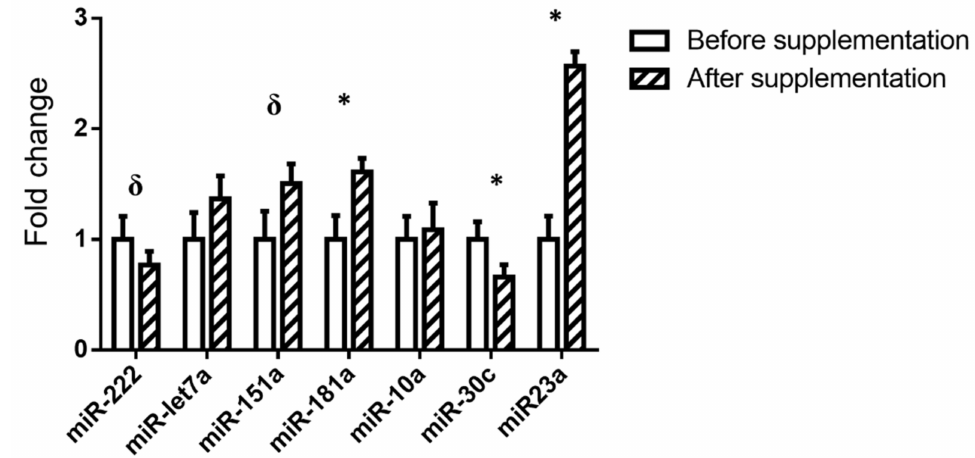
Figure 2. Relative miRNA expression in the whole cohort before and after the supplementation with grape pomace. The 2ˆ-( ∆∆ Ct) method was used to calculate fold changes, relative to the expression before supplementation. Values are presented as mean ± standard error of the mean. Comparisons were carried out using paired Student’s t -test or Wilcoxon’s signed rank test when required. * p < 0.05, δ p <